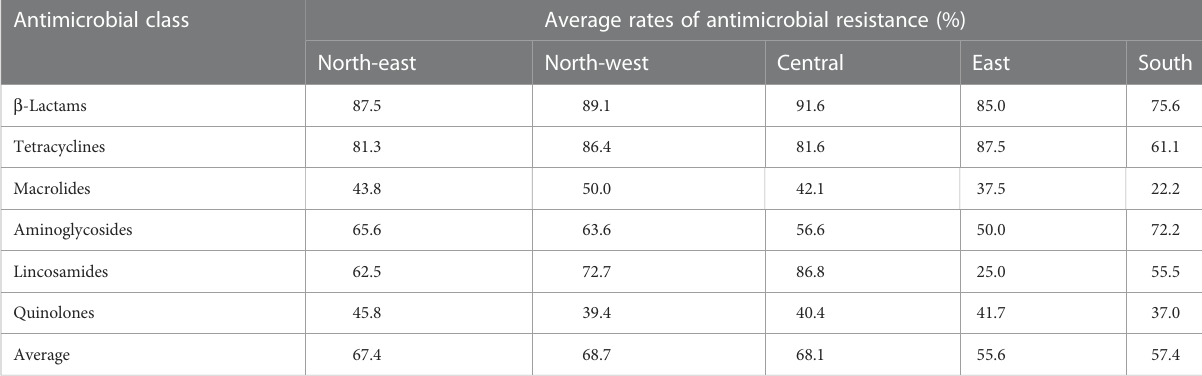
TABLE 5 The average rates of antimicrobial resistance of S. agalactiae isolated from goat milk samples in fi ve regions of China.